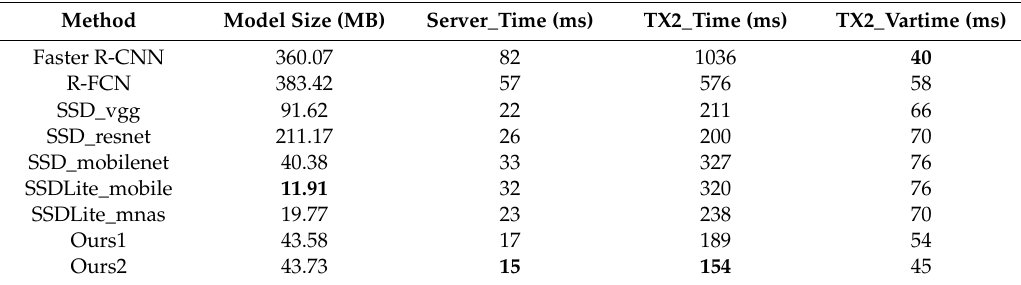
Table 4. Statistics of detection time of di ff erent algorithms; server_time: the average detection time of a single image on the server; TX2_time: the average detection time of a single image on TX2; TX2_vartime: variance of the detection time of the image on TX2. Note that the best results are